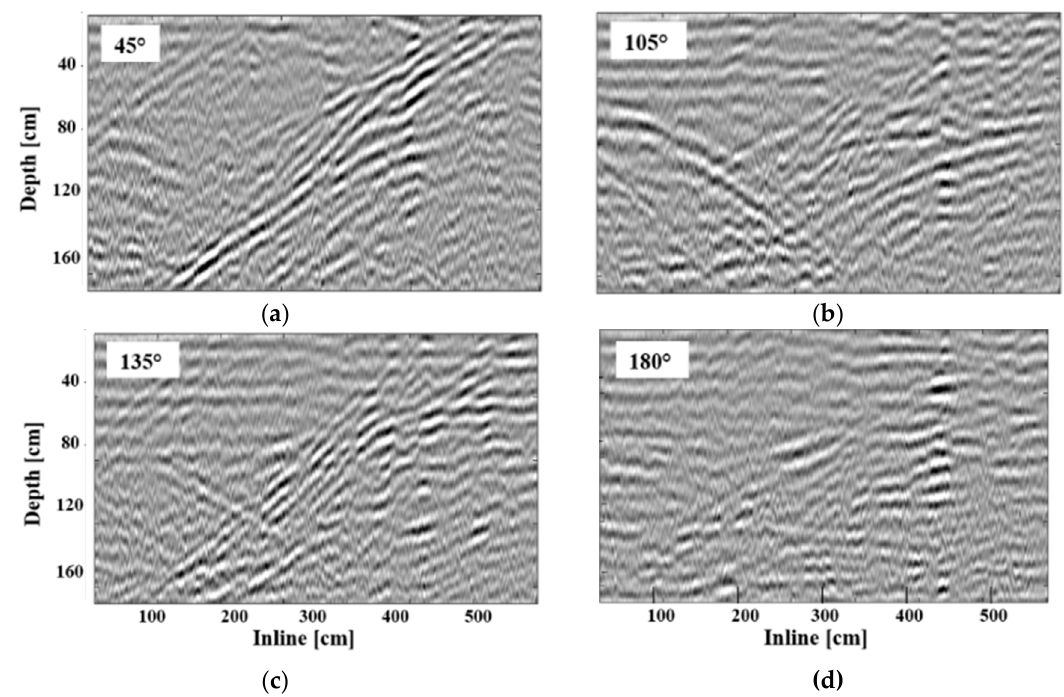
Figure 7. Highlight on fracture marked A: ( a ) Local maximum; ( b ) local minimum; ( c ) local maximum; and ( d ) local minimum.